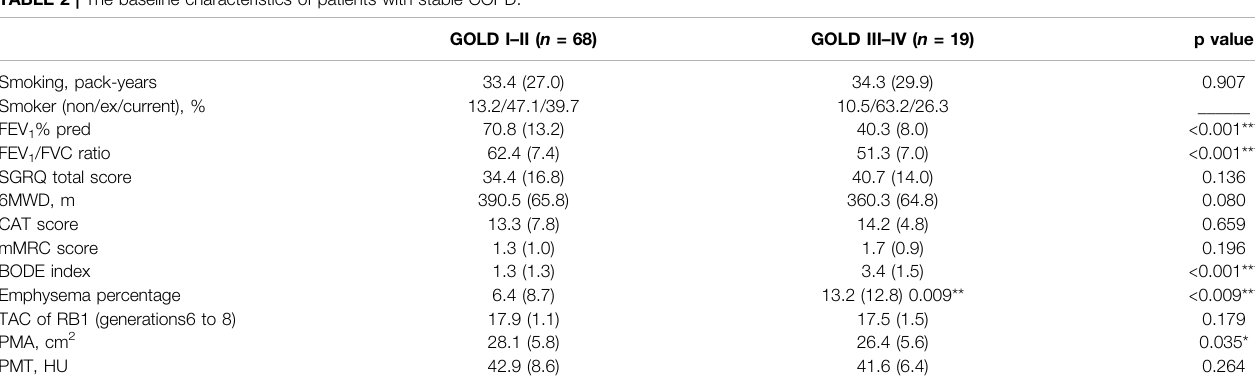
TABLE 2 | The baseline characteristics of patients with stable COPD.